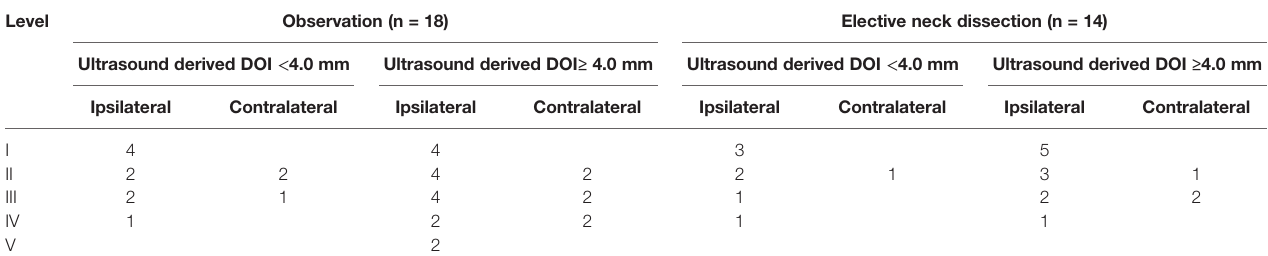
TABLE 2 | Neck recurrence pattern in the observation and elective neck dissection groups strati fi ed by different ultrasound derived depth of invasion (DOI).